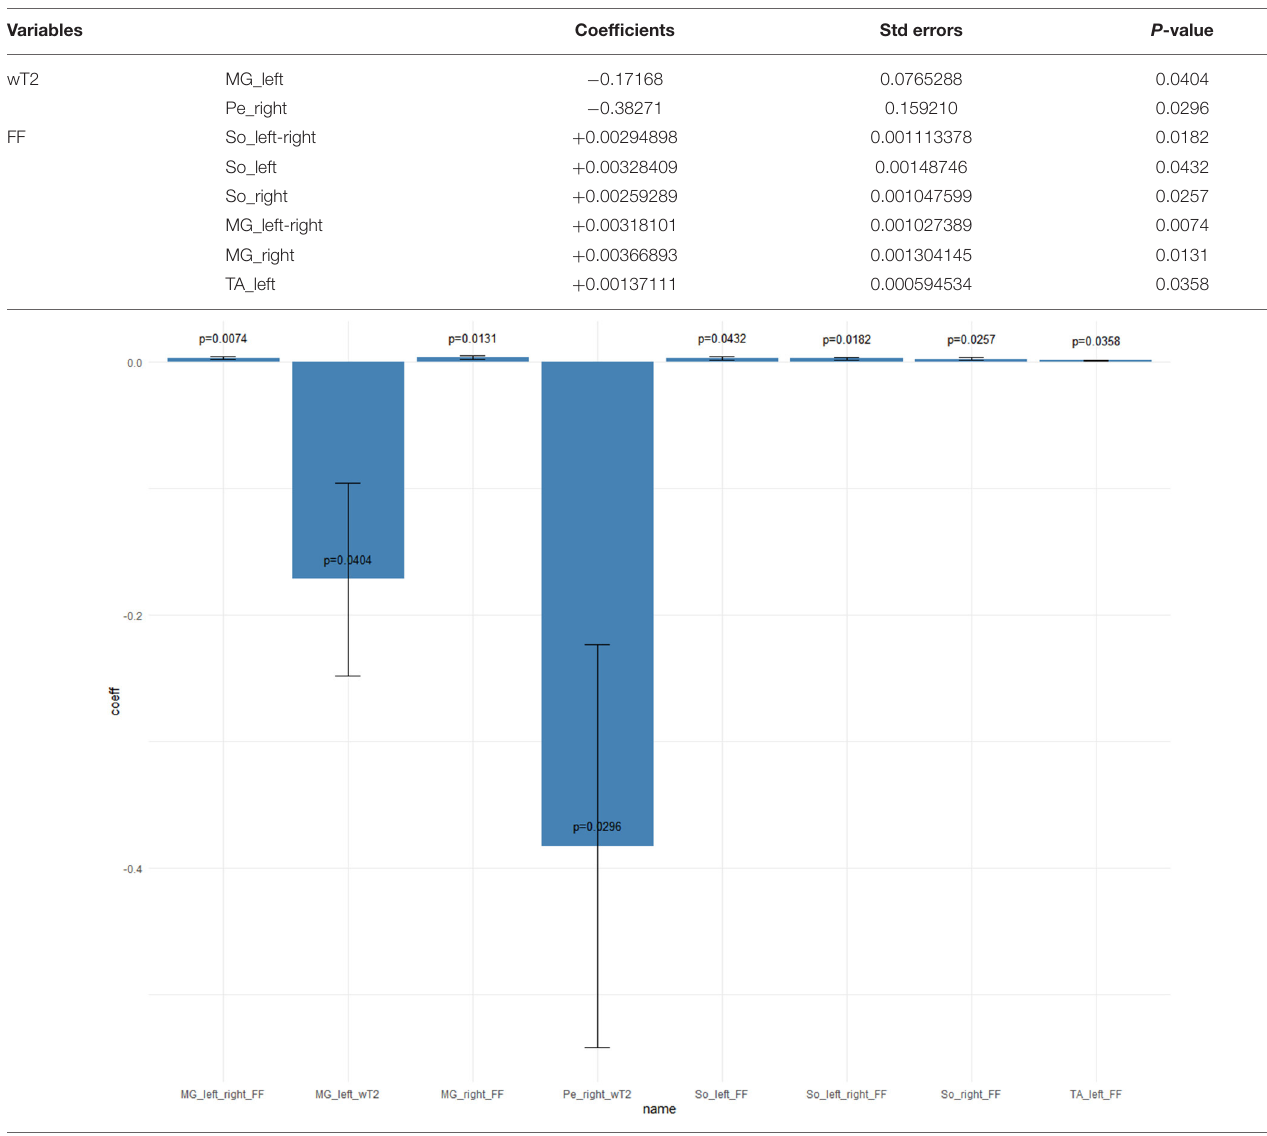
TABLE 3 | Longitudinal qMRI evaluation of ALS subjects—mixed effects models results when time is the explanatory variable of the model.